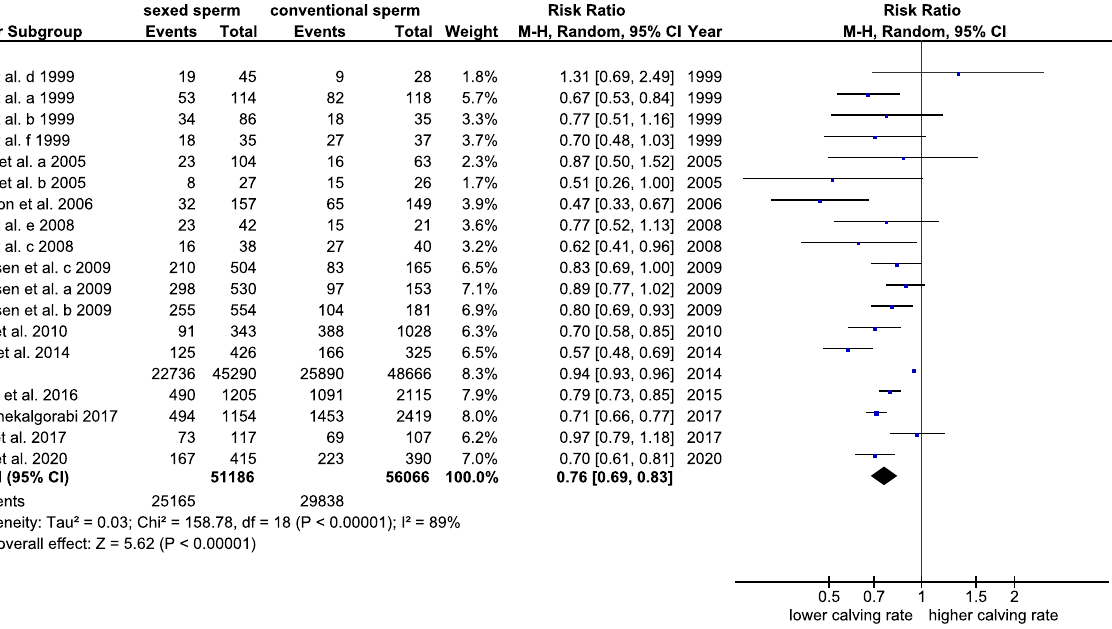
Figure 5. Forest plot of the calving rates after the use of sex-sorted sperm compared to conventional The effects of frozen and fresh semen on the calving rates were analysed in 13 and 2 trials, respectively. Calving rates after sex-sorting were significantly decreased (p < 0.001) after freezing and thawing. The rate ratio was 0.77 (CI 95: 0.68–0.86) for frozen semen and 0.95 (CI 95: 0.87–1.03) for fresh semen pointing to a reduction of 18 percentage points in calving caused by the freezing of the sex-sorted sperm (p < 0.001, Cochran–Mantel–Haenszel test Table 3). The heterogeneity was high in frozen sperm (I 2 : 63%, tau 2 : 0.03, p < 0.001, chi-square test, Table 3) whereas the heterogeneity was low in fresh sperm (I 2 : 3%, tau 2 < 0.01, p = 0.31, chi-square test, Table 3). The effect of a sperm dosage with more than 2.5 million sperm per straw (4 million) was only investigated in 2 trials. The effects of 2.5 million sperm or less on the calving rate were investigated in 16 trials. Overall, there was no significant impact of the sperm dose on the calving rate ratio (p = 0.450, Cochran–Mantel–Haenszel test, Table 3). For 2.5 million sperm (or less) per straw the RR was 0.76 (CI 95: 0.68–0.85) and for the increased concentration > 2.5 million sperm the RR was 0.69 (CI 95: 0.57–0.85, p < 0.001 for ≤ 2.5 million, p = 0.001 for > 2.5 million sperm per straw) (Table 3). When comparing the effects of sperm sexing on calving rates in the trials published between 1999–2015 and in the trials published between 2016–2020 calving rates increased from 39.9% (CI 95: 33.4–46.4) to 46.5% (CI 95: 29.6–63.5) in sex-sorted sperm and from 53.7% (CI 95: 45.7–61.6) to 58.3% (CI 95: 49.7–66.9) in conventional sperm (Table 3). The RR increased from 0.74 to 0.77 (p = 0.69, Cochran–Mantel–Haenszel test, Table 3) point- ing to an improvement of calving rates after sex-sorting of 3 percentage points after 2015 (Table 3). Further to that, the heterogeneity was higher in the trials published before 2015 (I 2 : 82%, tau 2 : 0.04, p < 0.001, chi-square test Table 3) compared to those published 2015 or later (I 2 : 71%, tau 2 : 0.01, p = 0.020, chi-square test, Table 3). When correlating the calving rates with the publication year over the whole period (1999–2020) no significant relationship was found (Spearman rho = − 0.116, p = 0.637, number of trials: 19). In a last step the impact of herd management on calving rates was investigated. When comparing calving rates after insemination during natural estrus (10 trials) and after synchronization (9 trials) calving rates were not sig- nificantly different irrespective of the use of conventional or sex-sorted sperm (p = 0.183 and 0.261, respectively, t-test, Table 3). The negative impact of sex-sorting on calving rates was similar after inseminations during estrus or after synchronisation (p = 0.990, Cochran–Mantel–Haenszel test). Consequently, the RR was the same (0.75) after insemination during estrus and after synchronisation (CI: 0.66–0.86 and 0.69–0.84, respectively, p < 0.001, Cochran–Mantel–Haenszel test). The heterogeneity was reduced after synchronization (I 2 : 93% for insemina- tion during estrus and 38%, for insemination after synchronisation, tau 2 : 0.03 and 0,01, respectively, p < 0.001, Table 3). Publication bias was not detected in the 19 trials analysed in the meta-analysis (Begg’s test, p = 0.087). A summary of the impact of sperm sexing on reproductive success is provided in Fig. 6. The comparison of NRR 24/60, pregnancy rates and calving rates after insemination with sex-sorted and conventional sperm showed that all these rates were significantly reduced after sex-sorting (Fig. 6). Overall, sex-sorting of sperm resulted in a 13% (9 percentage points) decrease of the NRR, a 23% (12.3 percentage points) decrease of pregnancy rate and a 24% (13.3 percentage points) decrease of calving rate (Fig. 6). Abortion rates. Abortion rates after insemination with conventional and sex-sorted sperm were compared in 18 trials. The abortion rates were similar when using sex-sorted and conventional sperm for insemination (8.8% (CI 95: 5.0–12.7) and 9.3% (CI 95: 4.4–14.2), respectively, p = 0.62, Cochran–Mantel–Haenszel test, Fig. 7). The odds ratio was 1.08 (CI 95: 0.8–1.45) indicating that the likelihood of the occurrence of an abortion